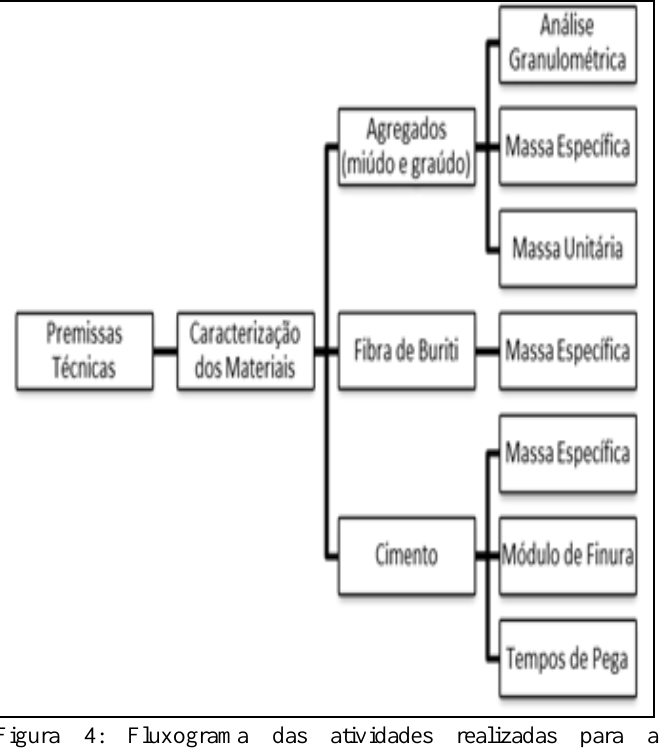
Figura 4: Fluxograma das atividades realizadas para a caracterização dos materiais.